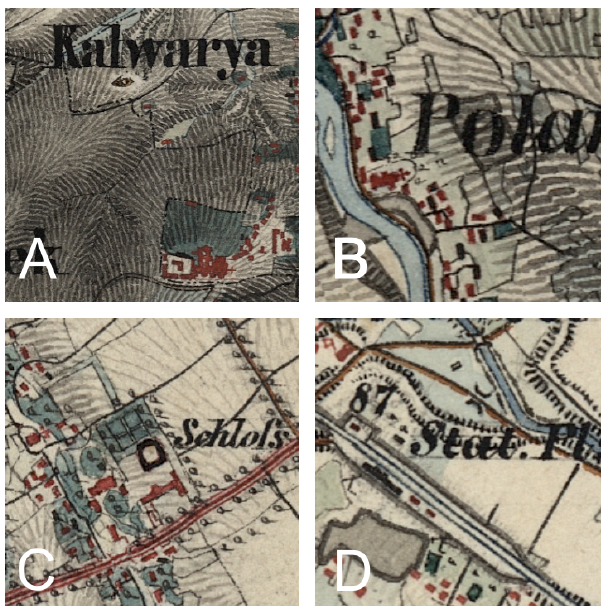
Figure 3. Examples of non-residential structures marked in red on the source map (a, b) and, less common, outbuildings marked in black (c, d) ; (a) monastery, (b) church, (c) sheepfold, and (d) rail- way station. Please note that in (c) , the textual information (Schloss) is related to the building marked in red (source: Austrian State Archives).